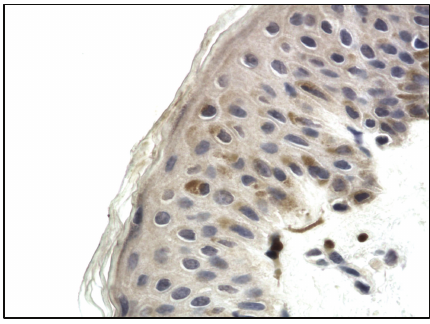
Figure 3: Fas ligand immunoexpression in the basal layer of the epidermis, (score 1), 400x.